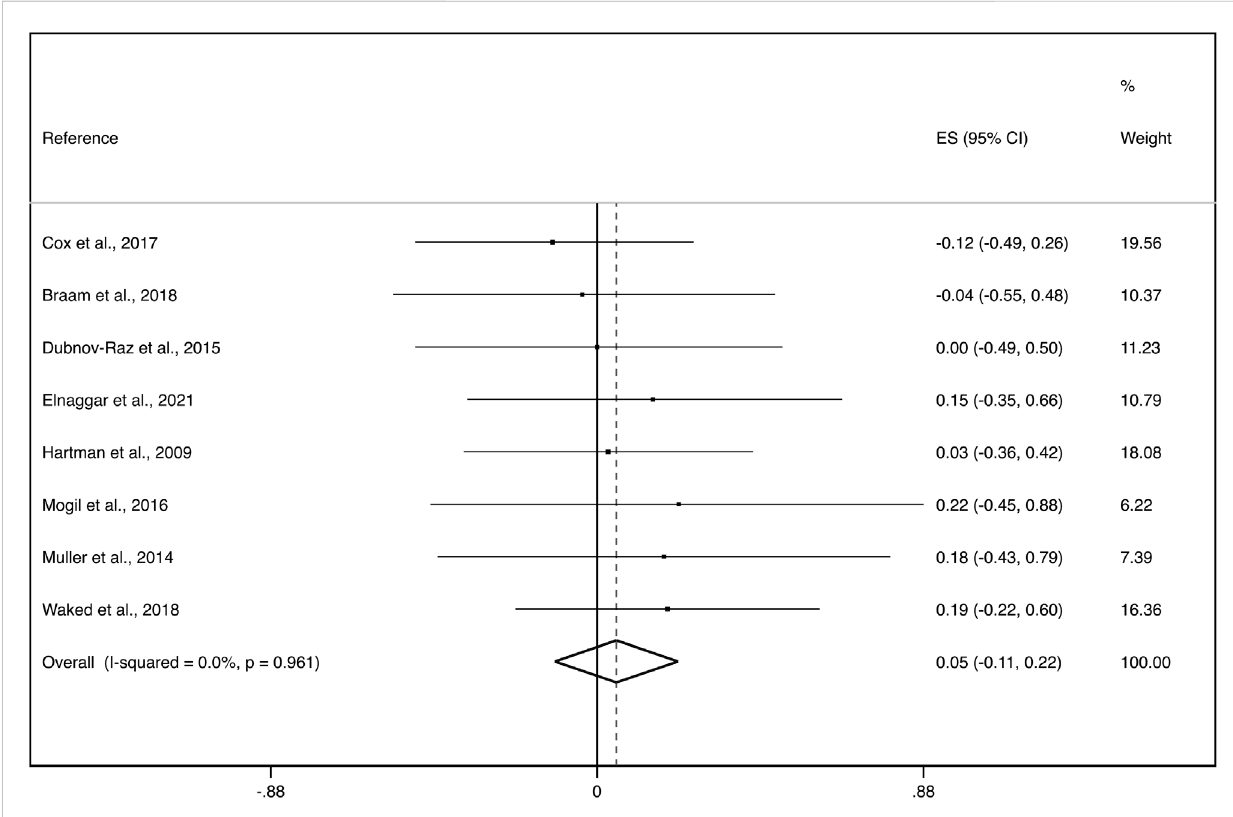
FIGURE 2 Forest plot of the effect size for the change in total aBMD. CI: con fi dence interval, ES: effect